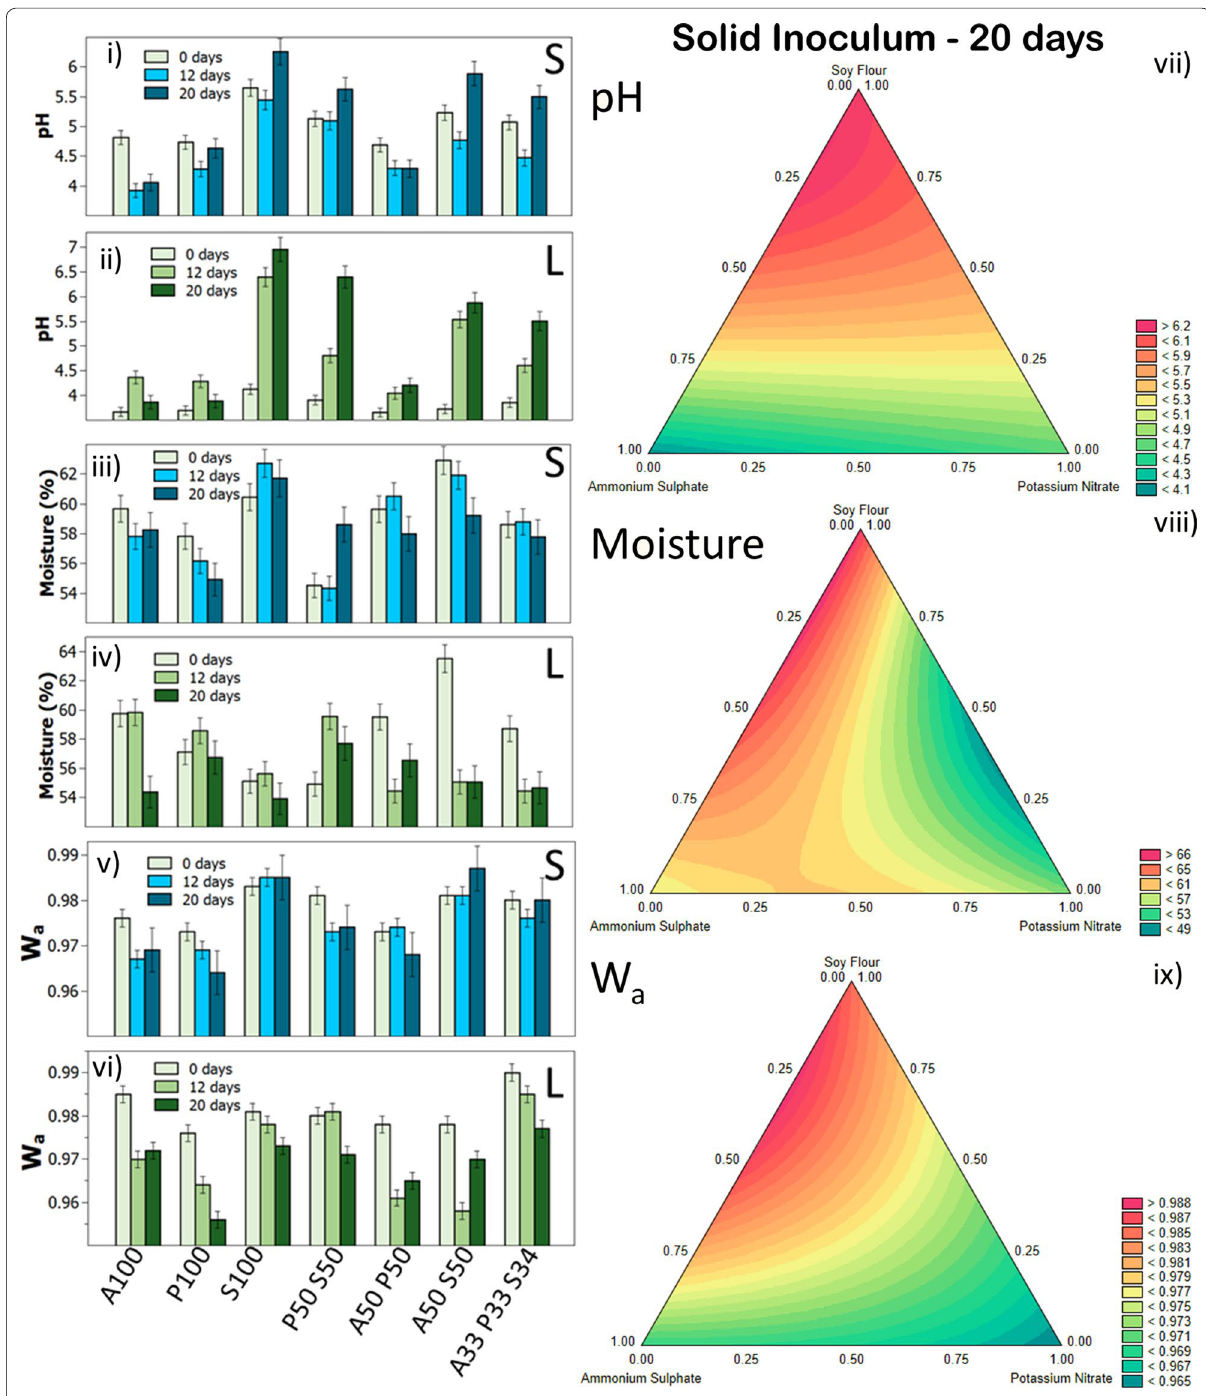
Fig. 1 Physico-chemical results in the studied time periods for pH, moisture, and water activity for solid (i, iii, v) and liquid (ii, iv, vi) inoculum, with their specific surface contour plot relating to a solid inoculum (vii–ix) at 20